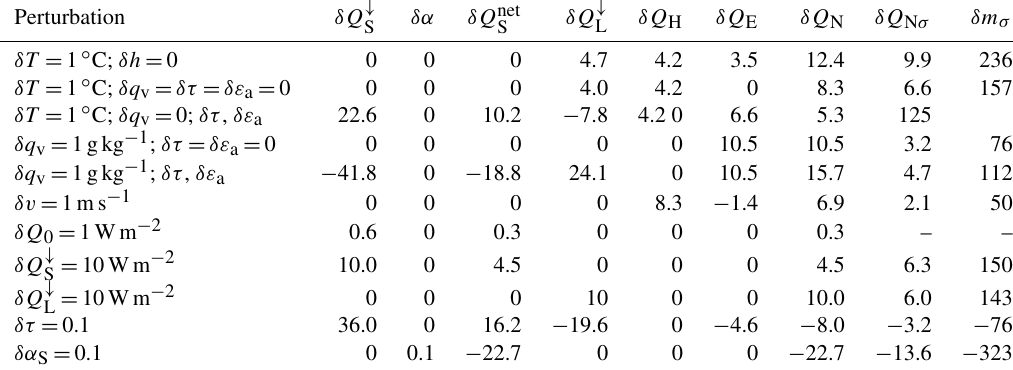
Table 3. Surface energy balance sensitivity to meteorological perturbations over a melting glacier surface, from direct feedbacks only. Calculations are for mean JJA conditions at Haig Glacier. All energy flux perturbations are expressed in Wm − 2 . δQ N σ is the net energy perturbation for a 1 σ increase in the variable. The melt perturbation, δm σ , has units of mmw.e. and is calculated assuming that δQ N σ holds for JJA (92